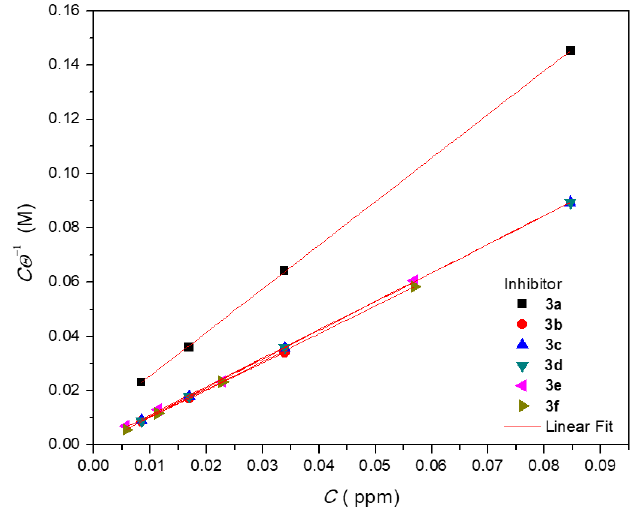
Figure 7. Adsorption isotherm of carbohydrate-xanthine conjugates. Table 3. Thermodynamic analysis of carbohydrate-xanthine conjugates immersed in HCl 1 M in API 5L X70 steel rates by means of the Langmuir model.